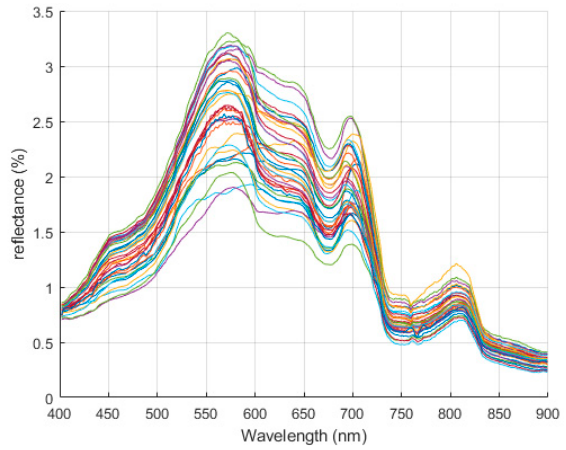
Figure 4. The 36 spectral curves extracted from the UAV-borne HRS images after the